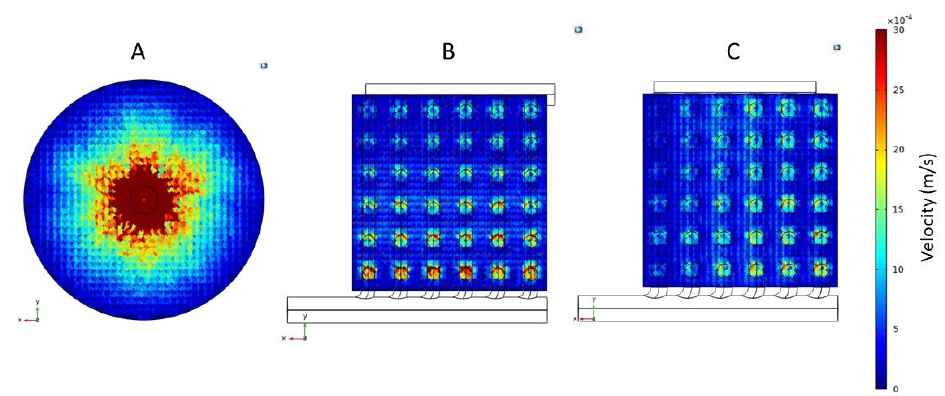
Figure 6. Overall velocity profiles for the fiber inlet plane of ( A ) Conventional cylindrical hemodia- lyzer. ( B ) Cuboid hemodialyzer 1. ( C ) Cuboid hemodialyzer